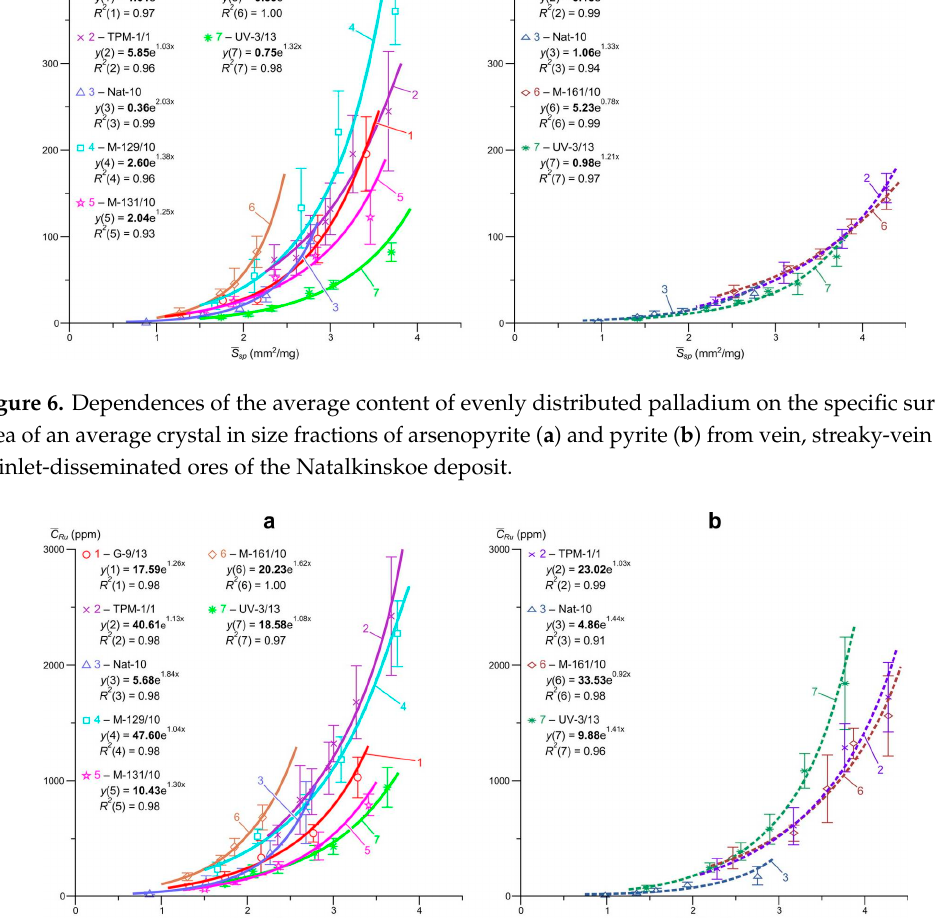
Figure 7. Dependences of the average content of evenly distributed ruthenium on the specific surface area of an average crystal in size fractions of arsenopyrite ( a ) and pyrite ( b ) from vein, streaky-vein and veinlet-disseminated ores of the Natalkinskoe deposit. Minerals 2020 , 10 , x FOR PEER REVIEW